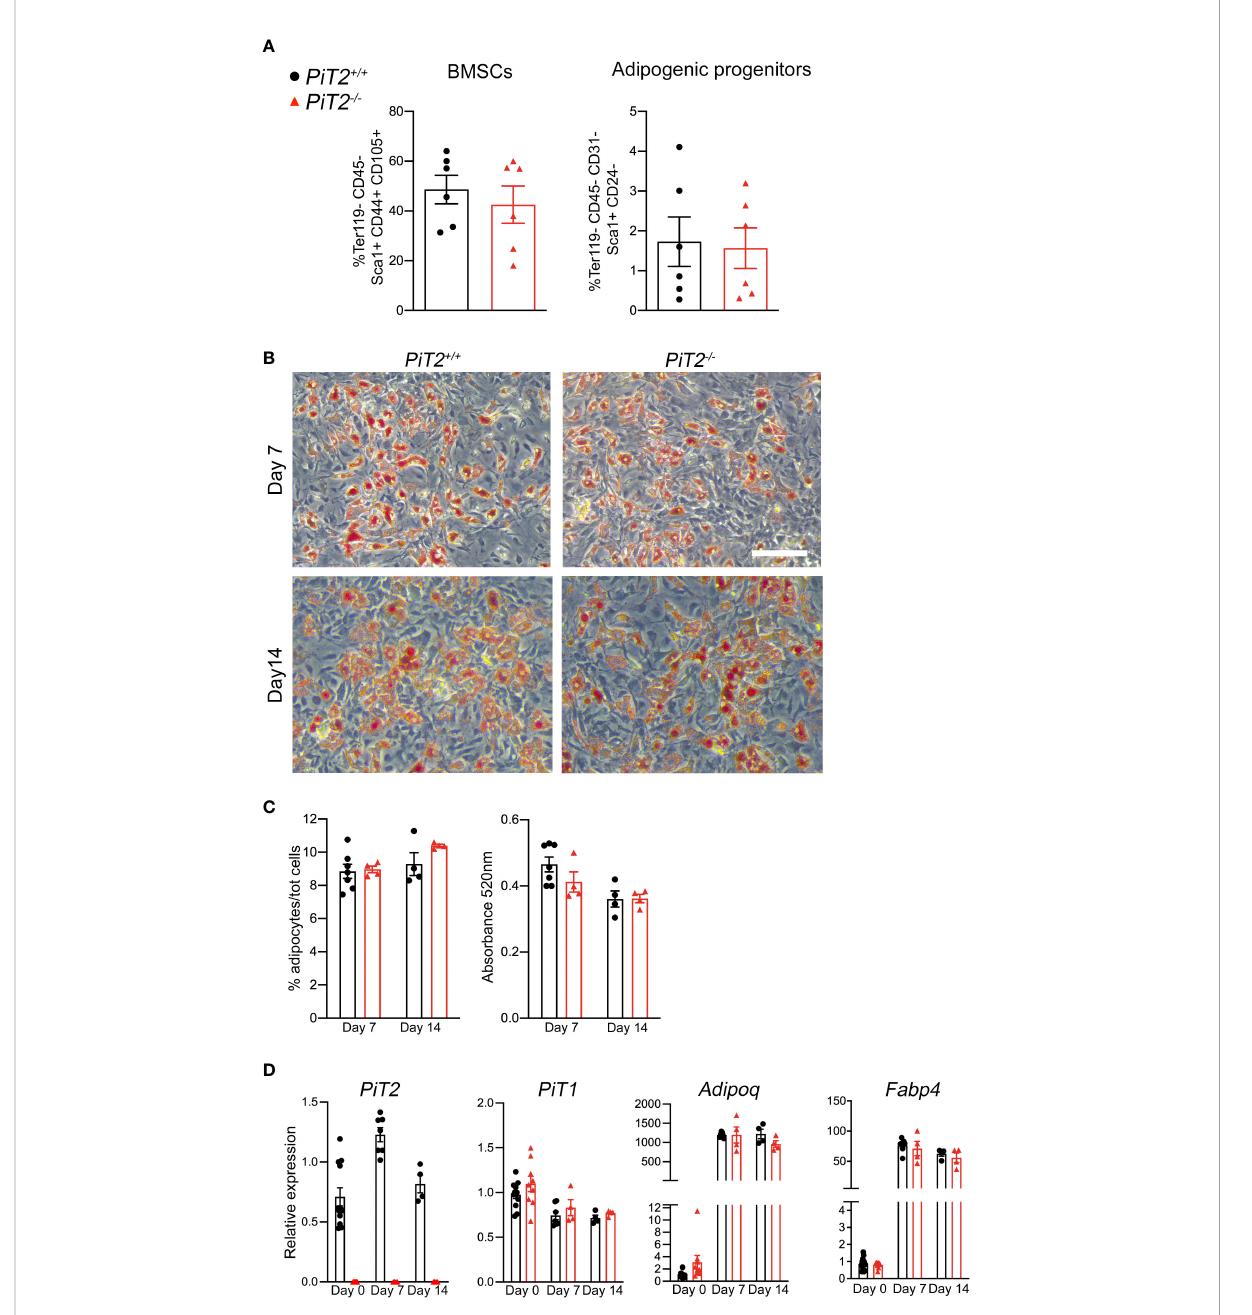
FIGURE 2 Characteristics of BMSCs in PiT2 -/- mice. (A) FACS quanti fi cation of BMSCs (Ter119 - CD45 - Sca1 + CD44 + CD105 + ) ( Left ) and adipogenic progenitors (Ter119 - CD45 - CD31 - Sca1 + CD24 + ) ( Right ) in the bone marrow of tibiae from 3-week-old PiT2 +/+ and PiT2 -/- female mice (n=6 per genotype). Data are means ± SEM, Mann-Whitney test. (B) Representative images of oil-red O (ORO) positive cells after adipogenic differentiation of PiT2 +/+ and PiT2 -/- BMSCs. Scale bar = 100 m m. (C) Quantitative analysis of ORO+ cells: Left , percentage of ORO+ cells related to the total number of Hoechst-positive cells; right , ORO absorbance at 520nm (D) Relative PiT2 , PiT1 , Adiponectin and FABP4 mRNA expression at 0 (n=12 PiT2 +/+ and n=9 PiT2 -/- ), 7 (n=7 PiT2 +/+ and n=4 PiT2 -/- ) and 14 (n=4 PiT2 +/+ and n=4 PiT2 -/- ) days of differentiation. N=3 independent experiments. Data are means ± SEM. Two-way ANOVA